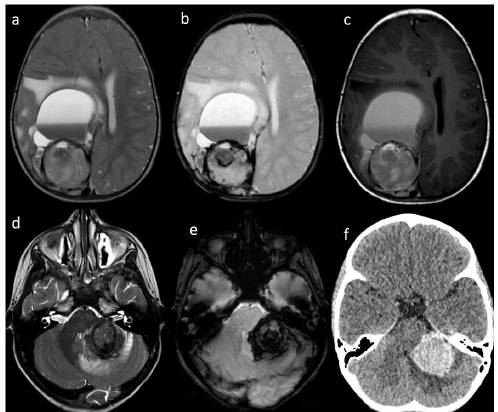
Figure 1. Patient #1 ( a , b , c ) and Patient #3 ( c , d , e ) imaging features. Axial T2w images of Patient #1 ( a ) and Patient #3 ( d ) shows a single bulky parenchymal lesion associated with mild surrounding vasogenic edema. Susceptibility-weighted imaging sequences in Patient #1 ( b ) and Patient #3 ( e ) show blooming within each lesion consistent with hemorrhage. Axial T1w image of Patient #1 ( c ) shows a solid-cystic appearance of the lesion with multiloculated blood-fluid levels in the most anterior portion and a solid hemorrhagic posterior component. Axial non contrast brain computed tomography (CT) of Patient #3 ( f ) shows lesion hyperdensity consistent with hemorrhage.